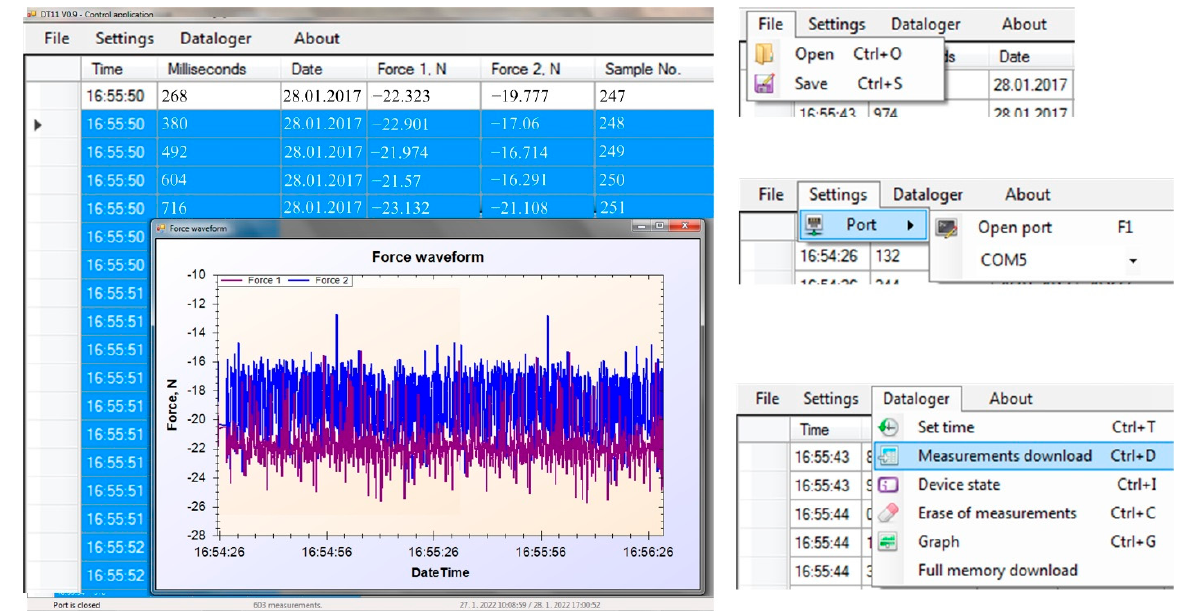
Figure 12. Software for the data acquisition system (the numerical data in the picture are for illustra- tion purposes only).